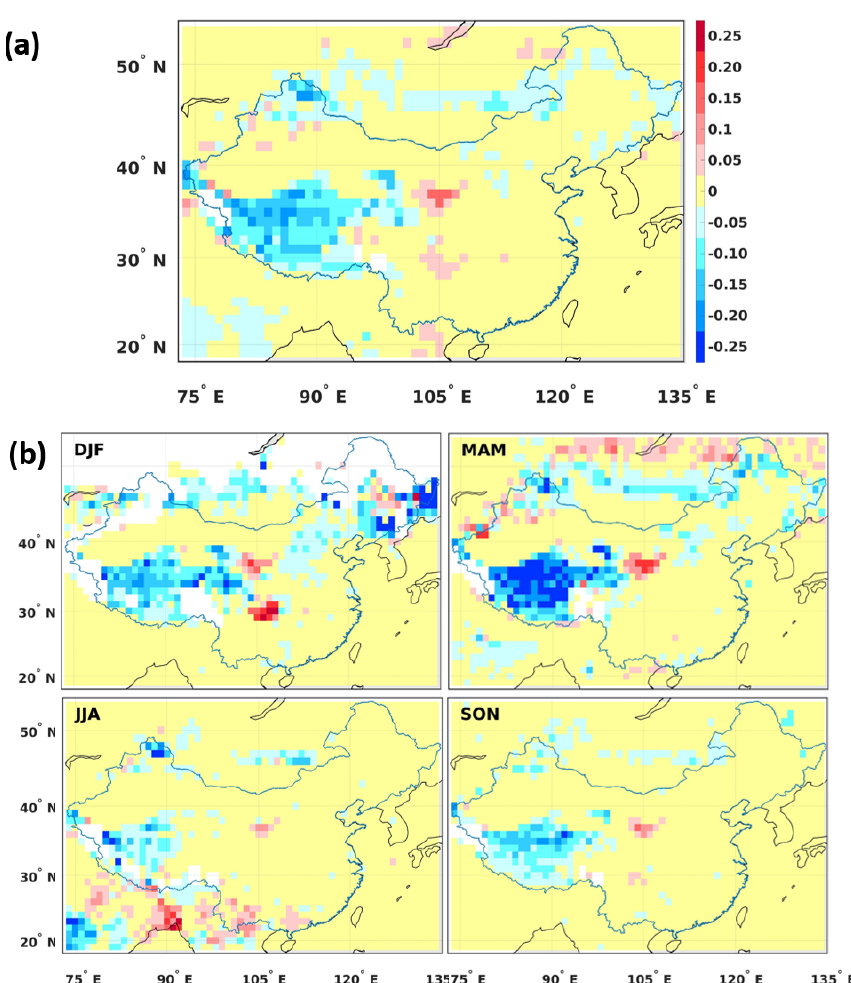
Figure 6. Difference between MODIS C6.1 and C6 DTDB merged AOD over China: annual averages for 2000–2011 (a) and seasonal averages for the same period (b) , where DJF represents winter, MAM represents spring, JJA represents summer and SON represents autumn). Areas for which no data are available are shown in white.